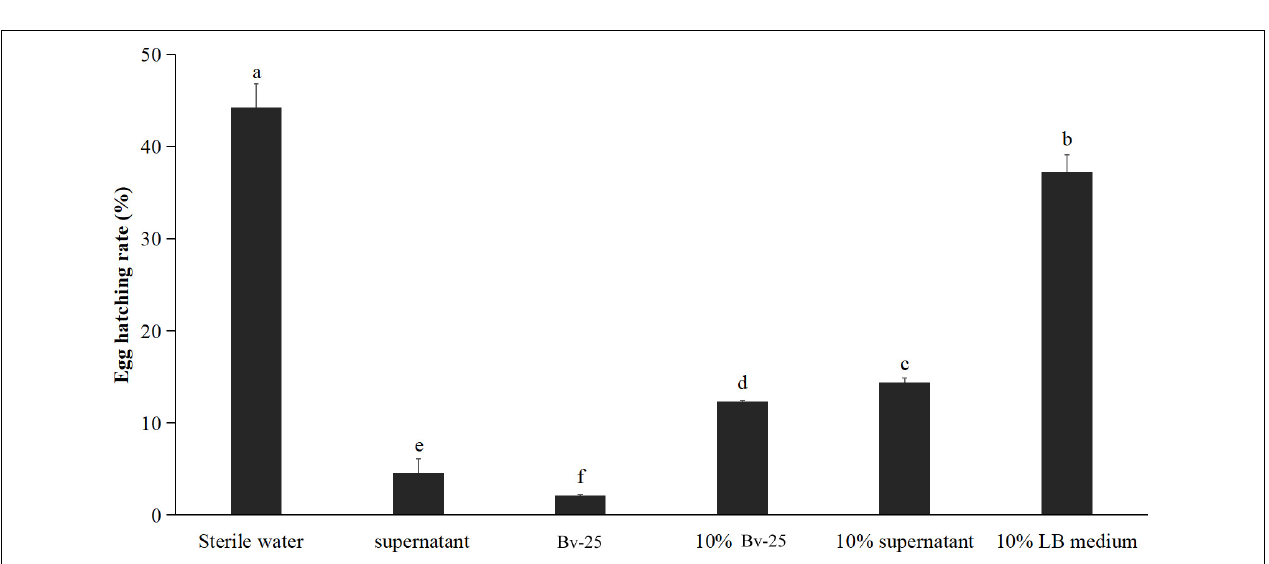
FIGURE 1 | Mortality rate of J2 treated by B. velezensis strain Bv-25 in vitro . Mortality rates were assessed by 300 J2s immersed in Bv-25 fermentation broth, 10% fermentation broth, bacteria-free supernatant, and 10% supernatant for 24 h at 28 ◦ C. Abamectin (1 µ g/mL) was a positive control, whereas sterile water served as negative control. Different letters indicate significant differences ( p < 0.05; n = 30) between treatments according to Duncan multiple-range test following one-way ANOVA.